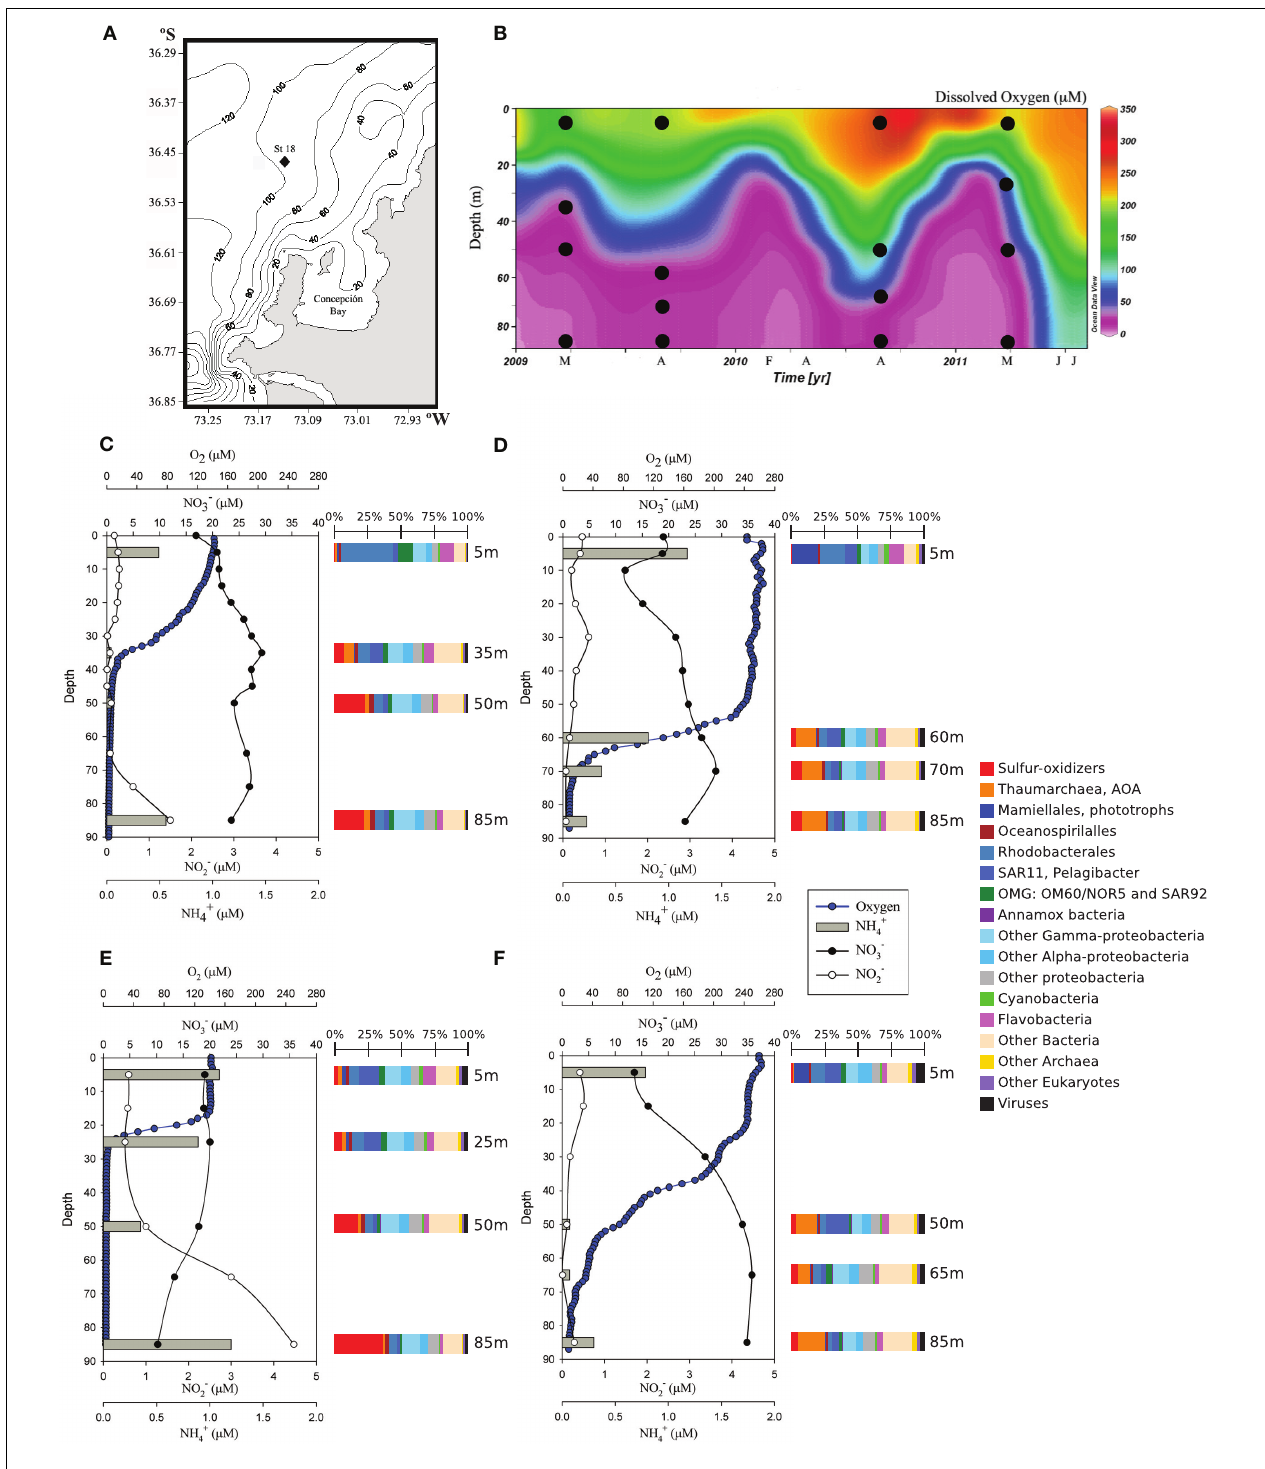
FIGURE 1 | Area of sampling and nutrient profiles in the water column. (A) Location of the time-series Station 18 off Concepción Bay. (B) Contour map for dissolved oxygen concentration in the water column at Station 18 during the 3-year period of the study. Depths sampled for metagenomics in March 2009 and 2011 (upwelling) and in August 2009 and September 2010 (non-upwelling) are shown as black